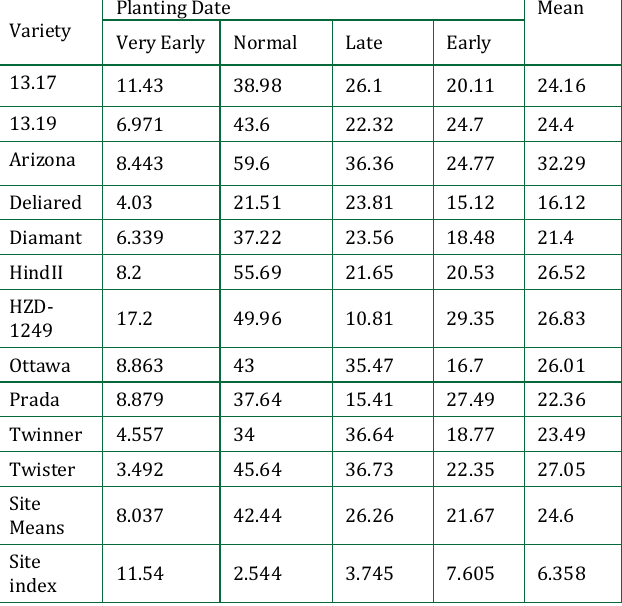
Table 3: Mean and AMMI stability of marketable tubers (tha -1 ) of 11 genotypes evaluated over four planting dates during the 2019-2020 cropping